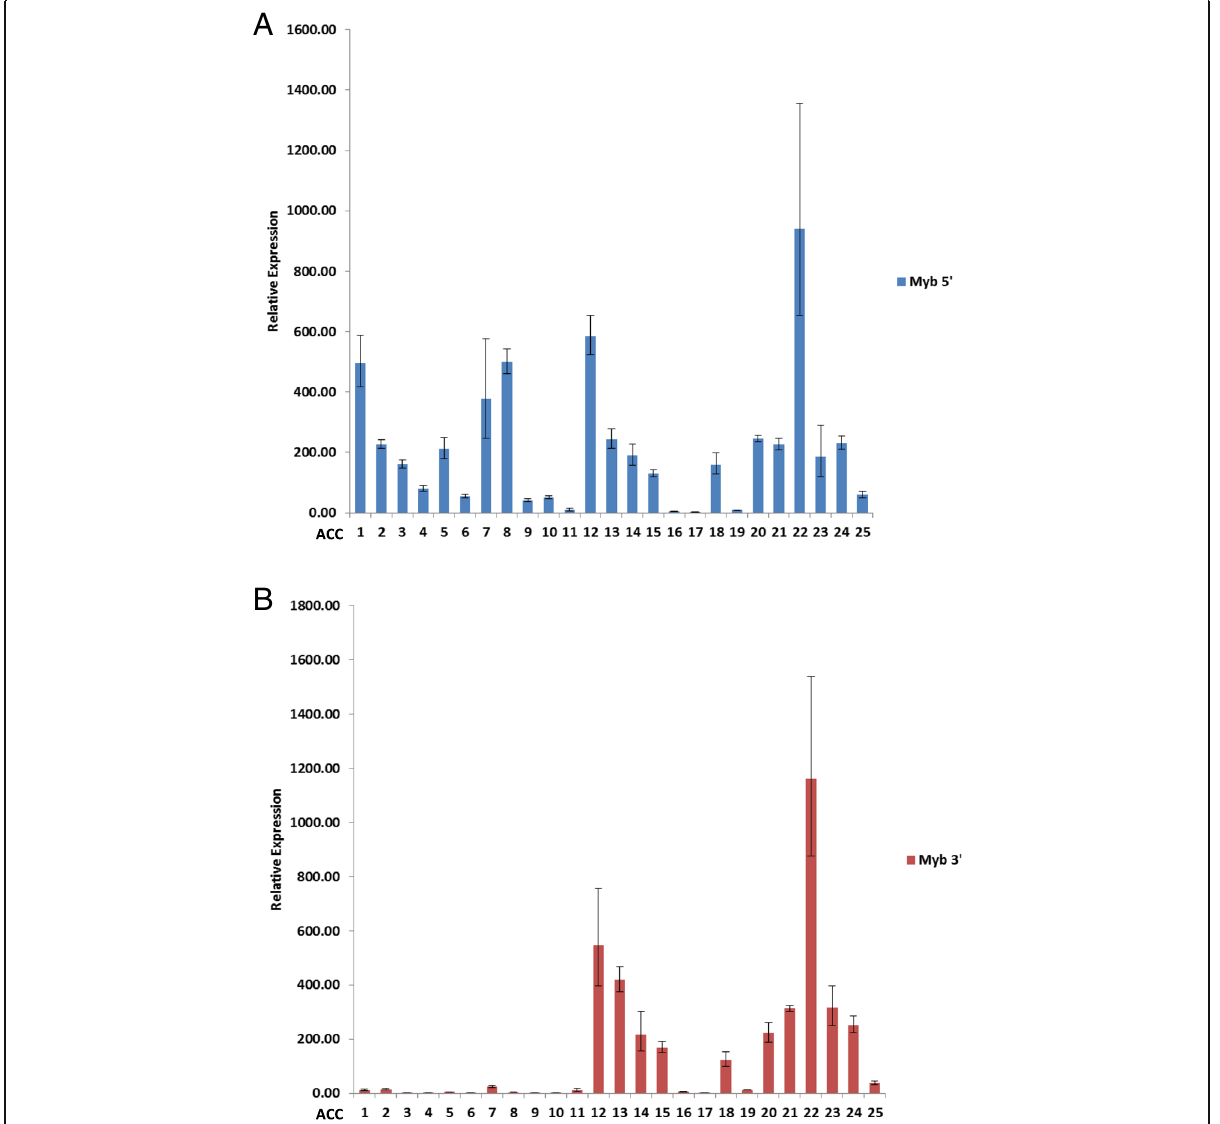
Fig. 2 Expression of MYB 5 ′ and MYB 3 ′ transcripts in 25 ACC cases by RT-qPCR. Relative expression of MYB 5 ′ transcripts ( a ) using primer/probe pairs that amplify coding exons 3 – 4 and MYB 3 ′ transcripts ( b ) using primer/probe pairs that amplify coding exons 14 – 15. Results are represented as fold increase expression relative to pooled normal